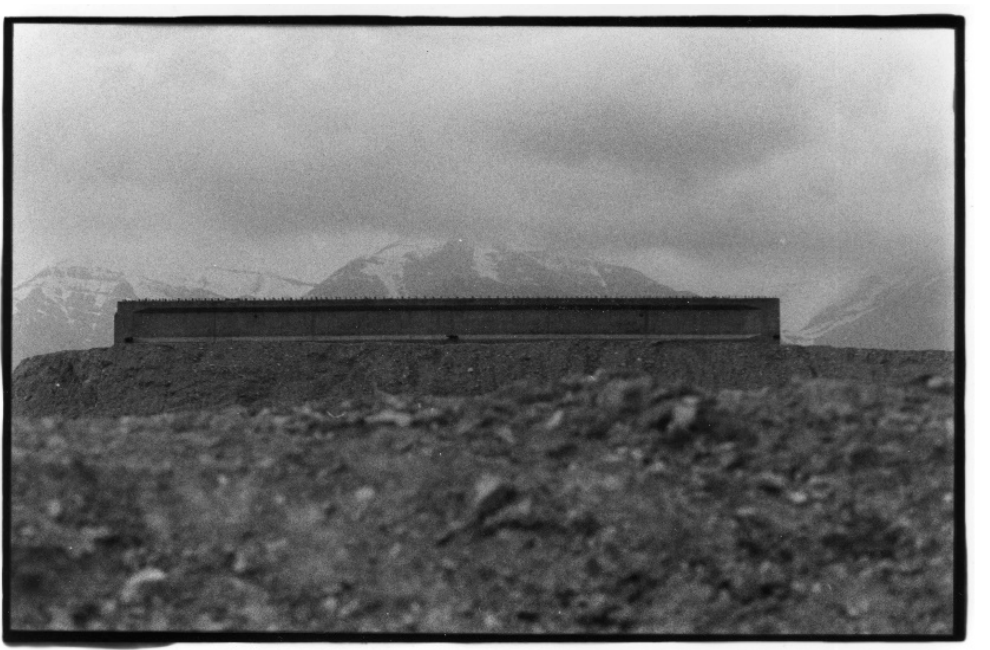
Figure 11. Mohammad Ghazali, from the Persepolis 2560–2580 series, Lost no. 024, 2001–2021, Analog photography, gelatine silver print, 13.5 × 20.5 cm.